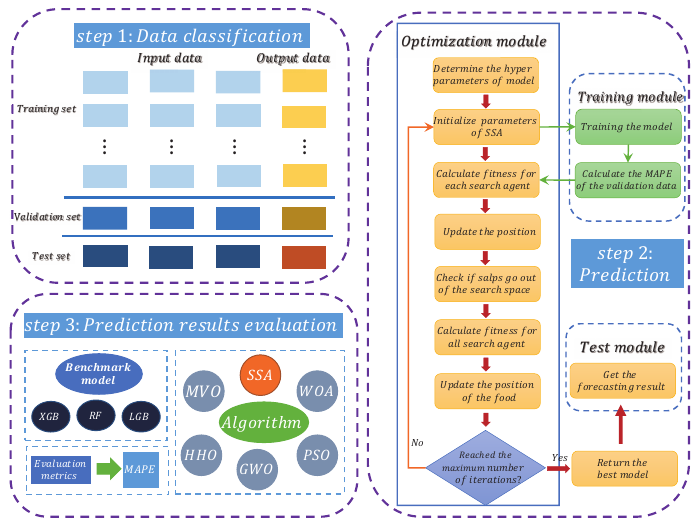
Figure 5. Complete computational procedures of the forecasting